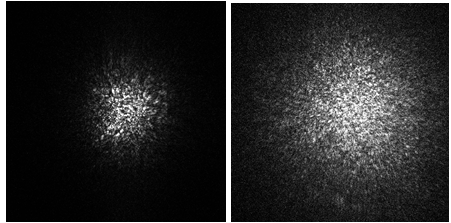
Figure 8. Star specklegrams (on the left – star №1, on the right – star №2)